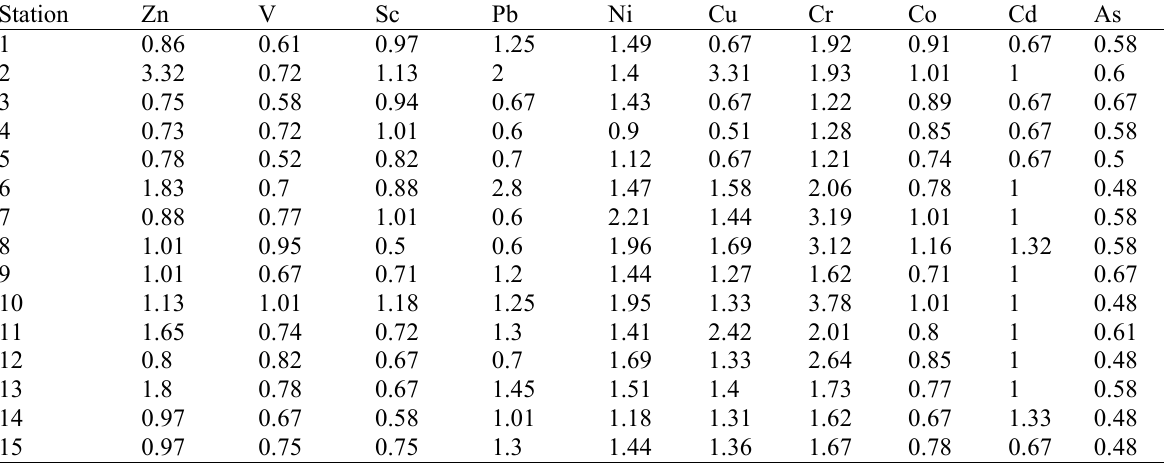
Table 5. Findings based on pollution factor in studied stations